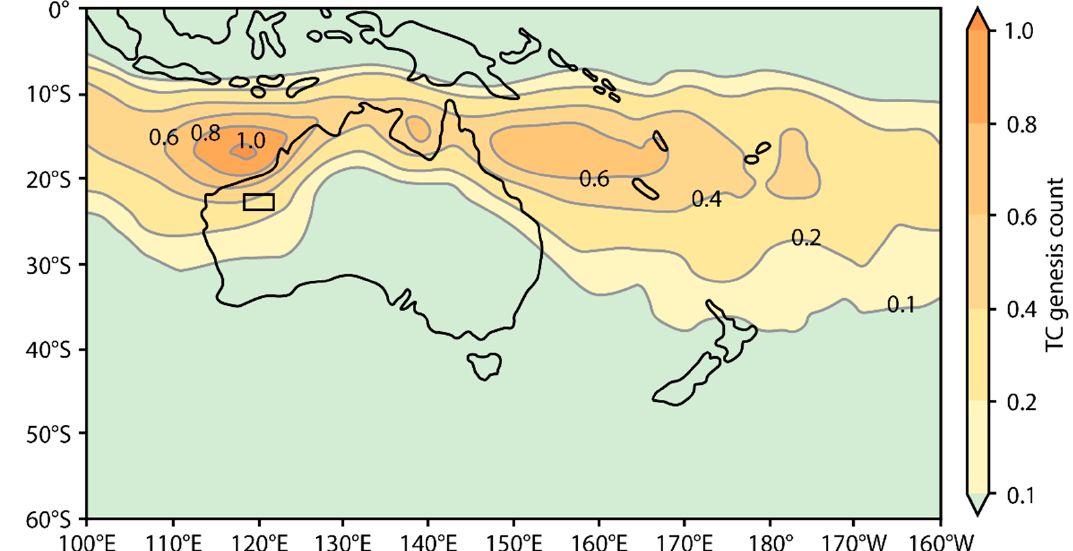
Figure 1. Observed Southern Hemisphere Tropical Cyclone genesis counts (all seasons) indicating the 122 average annual number of tropical cyclones through Australian region in El Niño, La Niña, and neutral 123 years (modified from Australian Government Bureau of Meteorology, 2019 [36]).